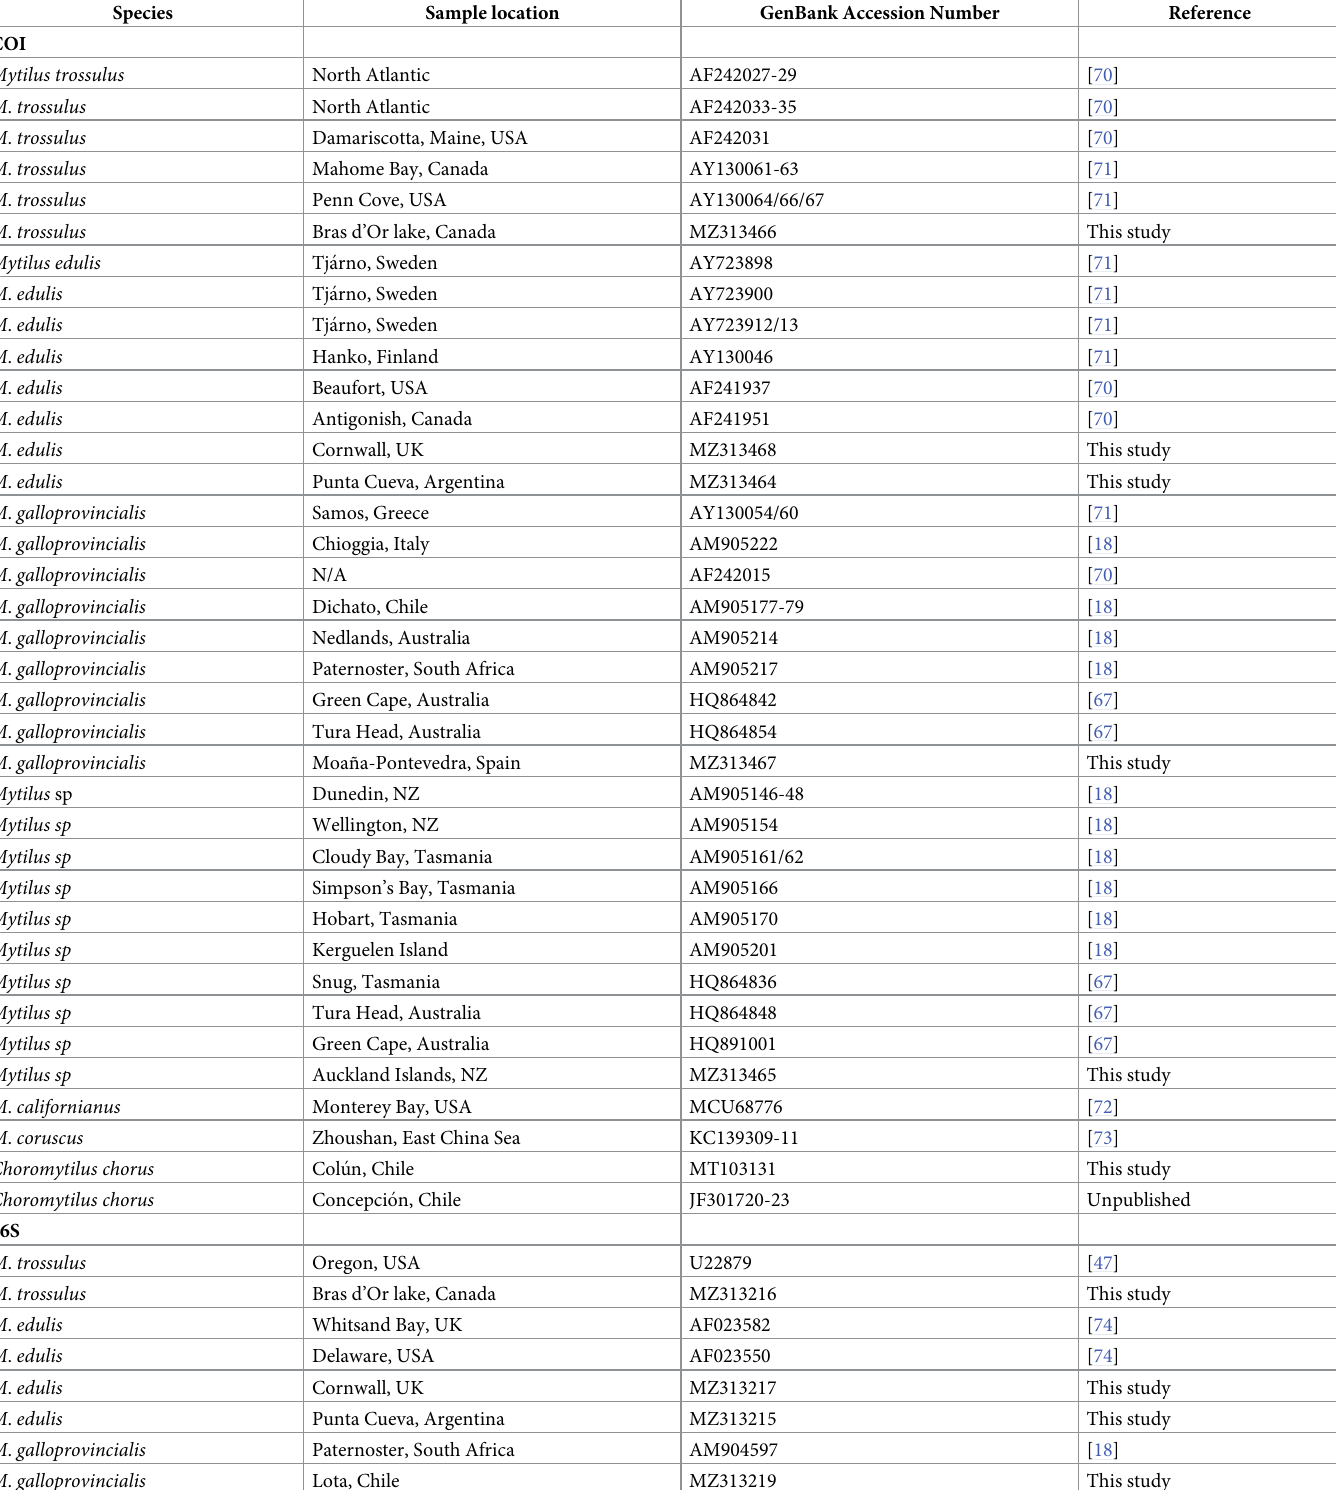
Table 2. GenBank accession numbers and sample locations of sequences used for this study for COI, 16S and 18S DNA sequence variation (for Figs 2 and 3).